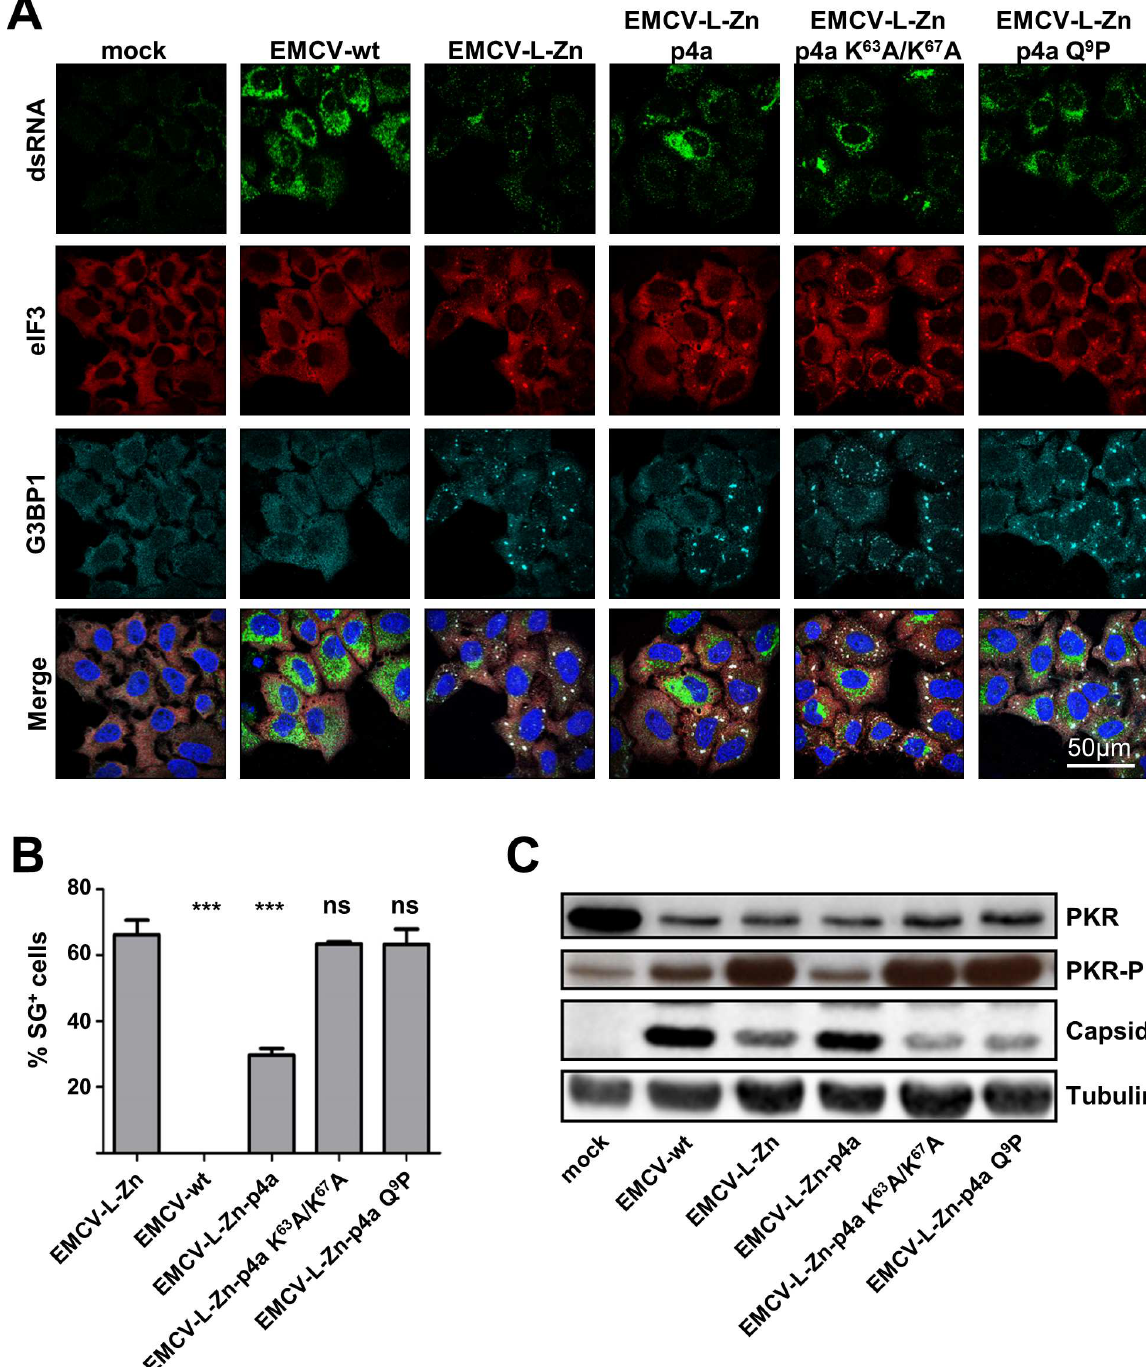
Fig 6. The dsRNA binding motif in MERS-CoV p4a is crucial for suppressing SG formation. (A) Immune fluorescence images of HeLa-wt cells that were mock-treated or infected with wt mengovirusor the indicatedrecombinantmengoviruses (MOI = 10). Cells were fixed at 6h post infection and stained for dsRNA (shown in green), eIF3 (shown in red), and G3BP1 (shown in cyan). Nuclei were stained using Hoechst-33258 (shown in blue). (B) SG-positive cells were quantifiedfrom three randomly selected images. Shown are means with standard deviations, analyzedusing an unpairedt-test ( *** , p < 0.001; ns, not significant). (C) Western blot analysis of PKR and phospho-PKR in cells infected with indicatedviruses. Capsid staining was used as a control for virus replication efficiency and tubulin staining was used as